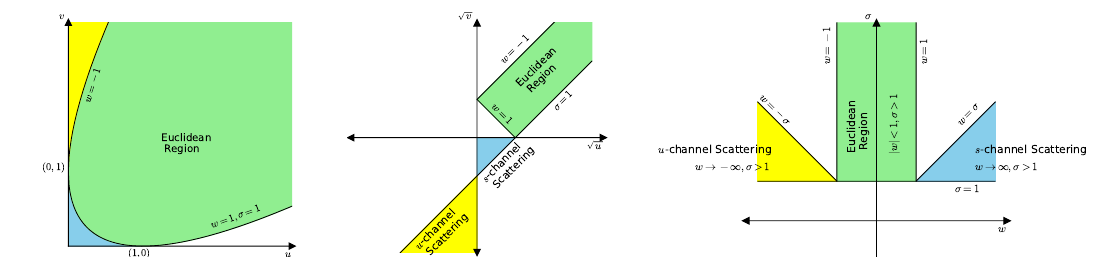
(cid:112) (cid:112) u , v plane, on to w , σ plane for